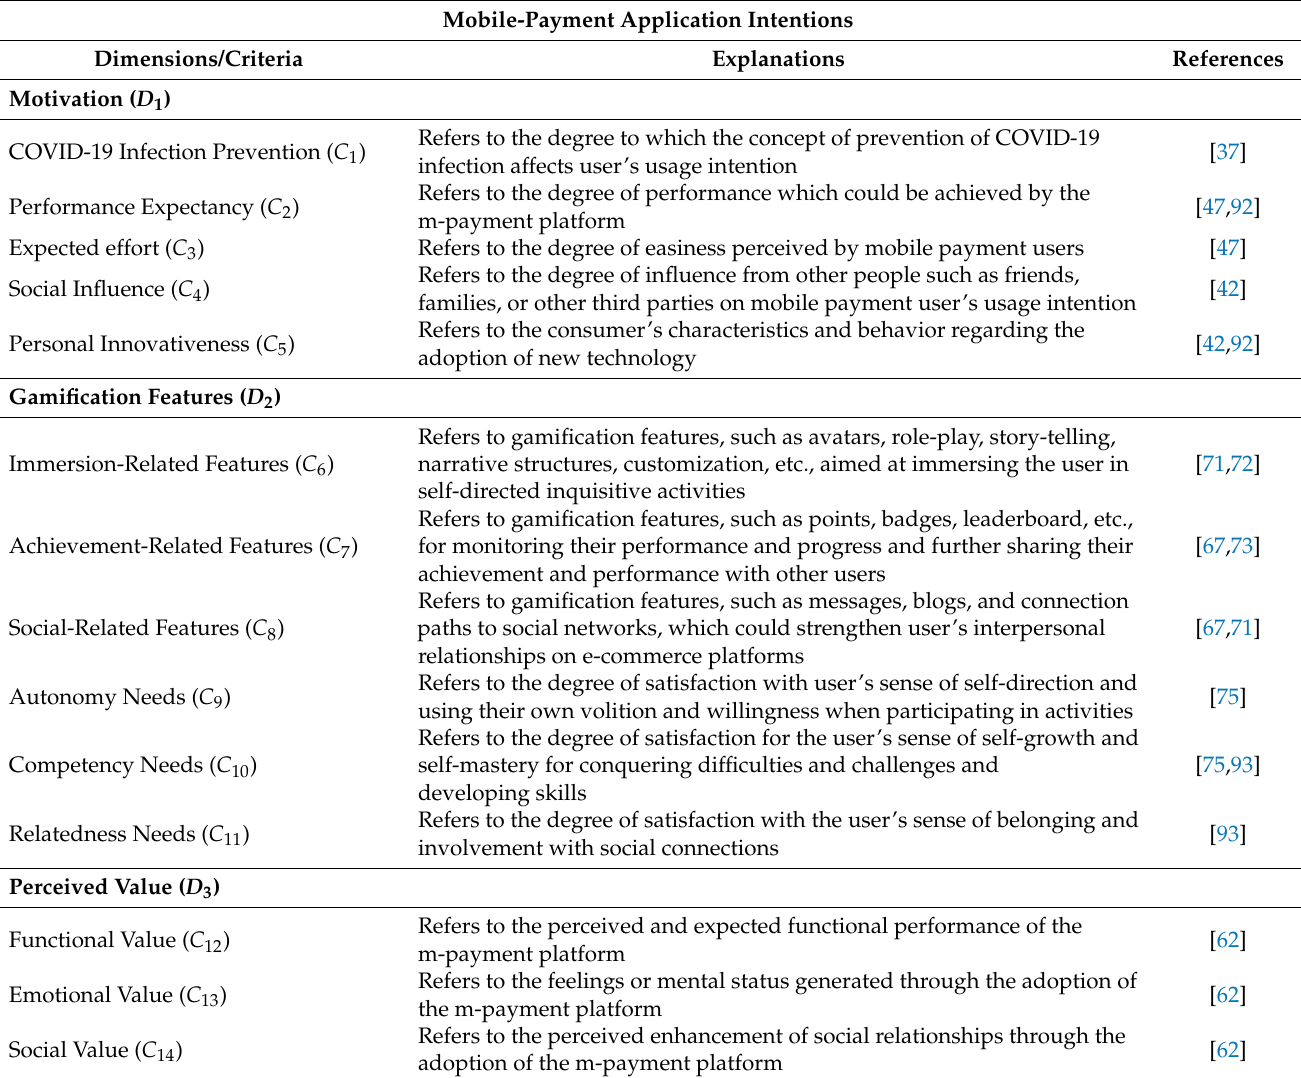
Table 1. The constructed evaluation